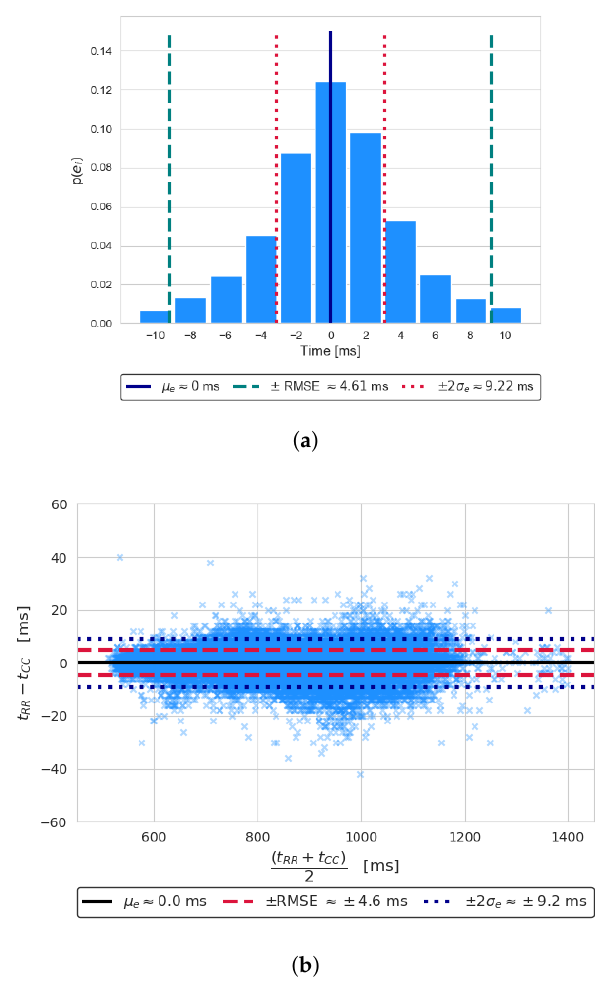
Figure 4. SCG events annotation performance: ( a ) error histogram, ( b ) Bland–Altman plot. Mean, RMS, and two times the standard deviation of errors are reported in the